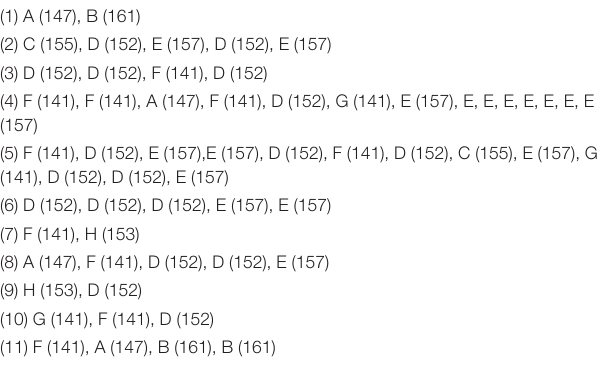
TABLE 1 | Males visited by marked individual